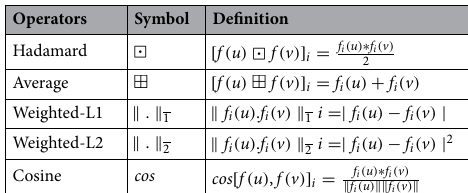
Table 3. Embedding operators used to predict edges in the tasks of link prediction and network reconstruction. The definitions describe the i th components of g ( u , v ).